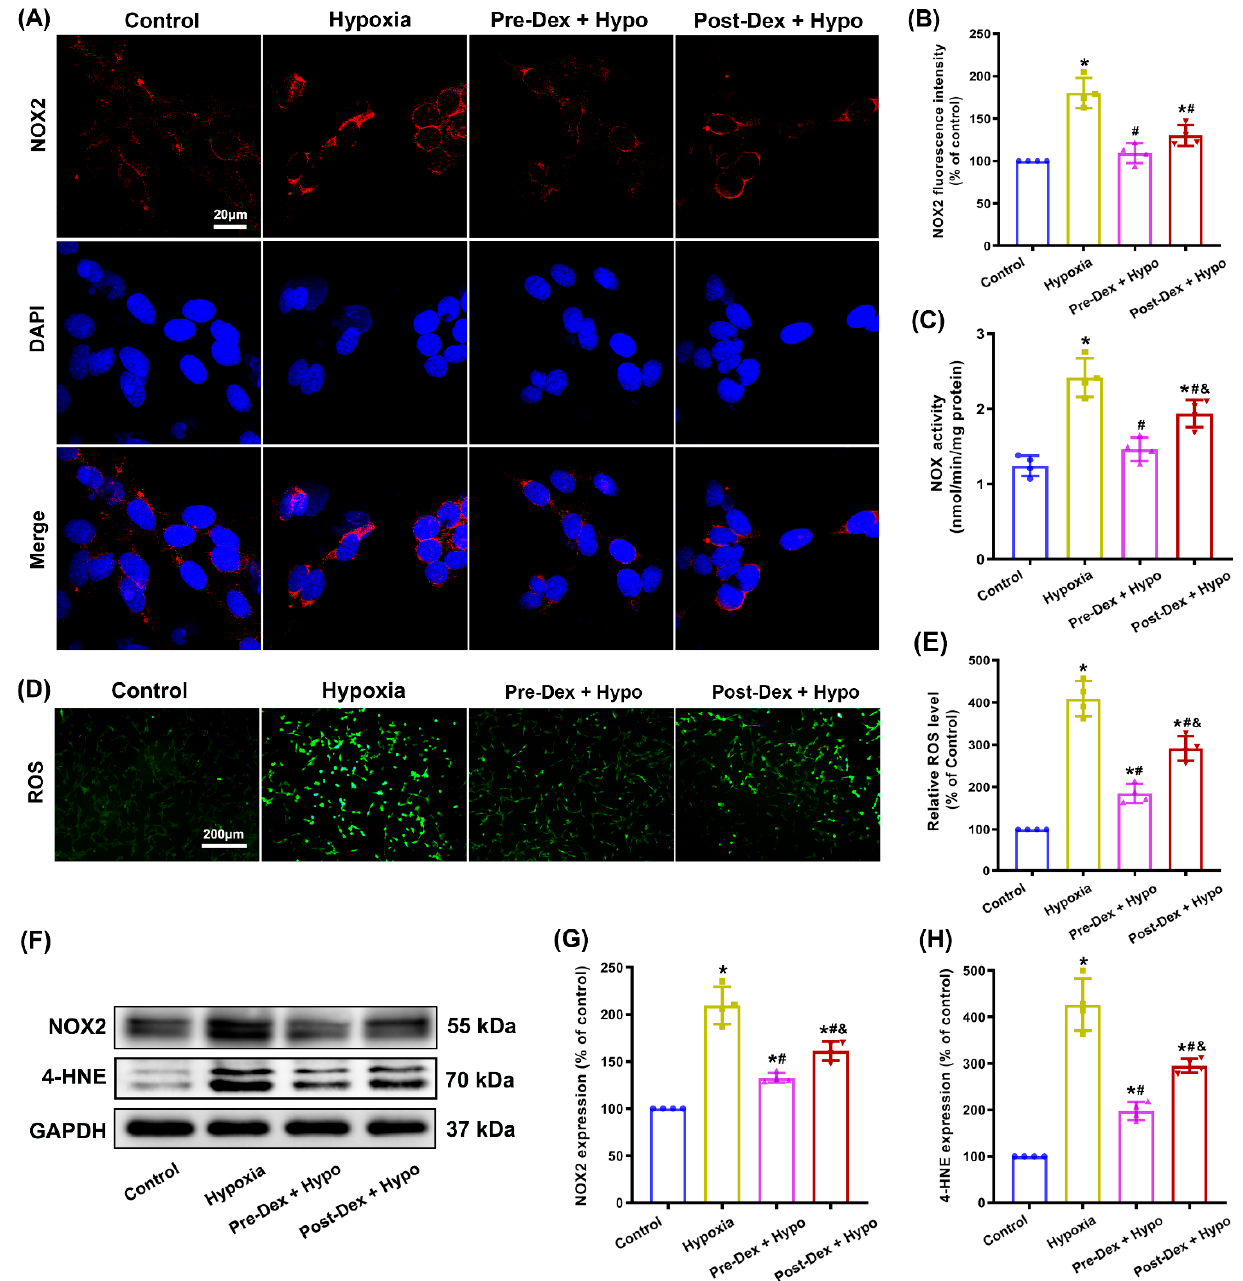
Figure 3. The effect of Dex on NOX2 activity and oxidative stress in cultured hippocampal neurons following hypoxia. ( A ) Representative confocal images stained for NOX2 (red) and DAPI (blue) in cultured hippocampal neurons. ( B ) The intensity of NOX2 fluorescence was quantified using ImageJ. ( C ) Cytochrome c reduction assays were used to measure NOX activity. ( D ) Intracellular ROS production was detected using the DCFH-DA probe. ( E ) The intensity of ROS fluorescence was analyzed using ImageJ. ( F ) NOX2 and 4-HNE protein levels were detected by Western blotting, and the relative expression levels of NOX2 ( G ) and 4-HNE ( H ) were analyzed using ImageJ. Results are expressed as mean ± SD ( n = 4 in each group). Each data point in the bar graph is also presented. * p < 0.05 versus the Control group; # p < 0.05 versus the Hypoxia group; & p < 0.05 versus the Pre-Dex group.